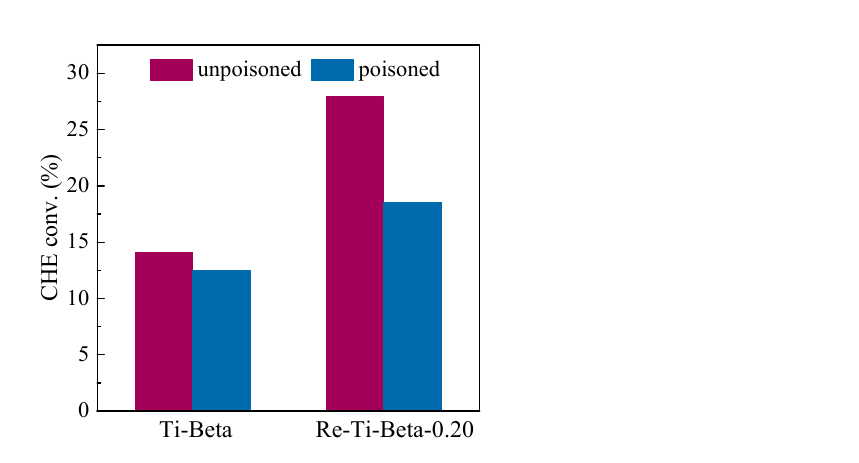
Figure 7. FT − IR spectra ( A ), Ti 2p XPS spectra ( B ) and UV − Raman spectra ( C ) of Ti − Beta (a) and Re − Ti − Beta − 0.20 (b).